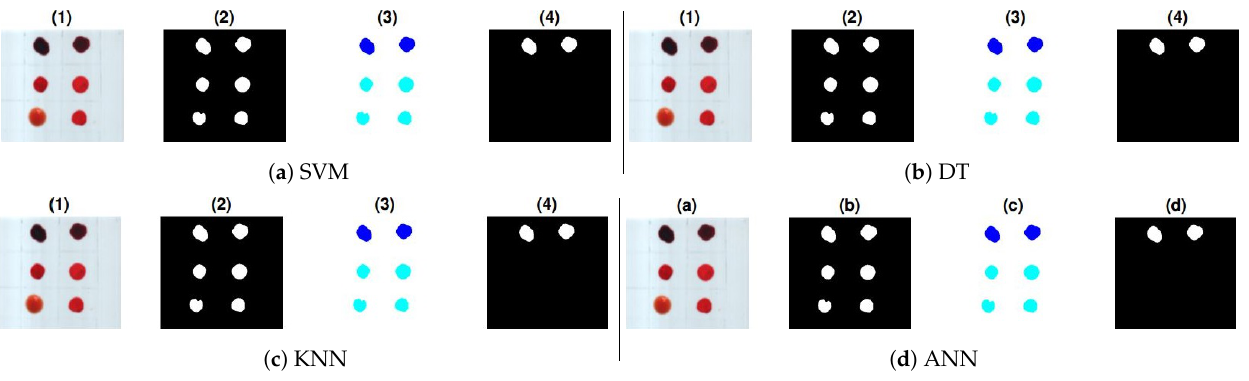
Figure 9. Prediction results of test samples on white tile: (1) True color image, (2) pre-processed image, (3) labeling, and